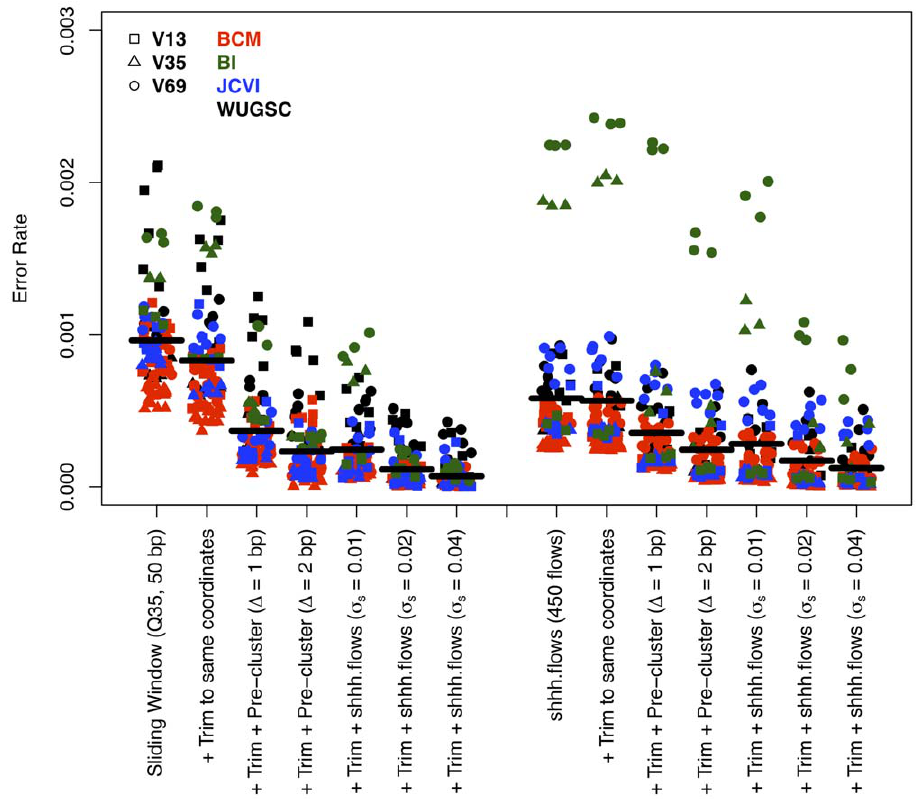
Figure 3. Effect of trimming sequences to the same alignment coordinates and using the pre-clustering or shhh.seqs algorithm on sequencing error rates when used within the sliding window and shhh.flows pipelines. The horizontal lines represent the average error rate across all samples within that treatment.